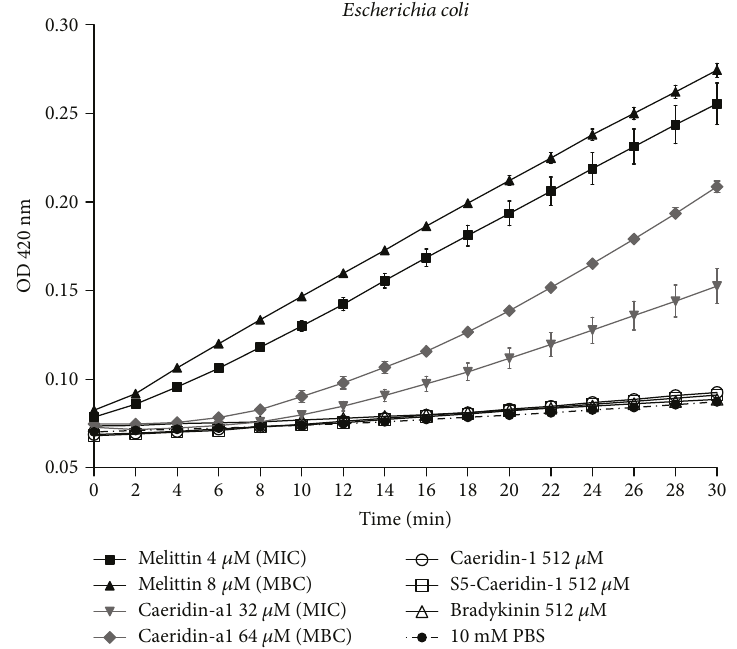
Figure 9: Membrane permeabilisation of E. coli treated with Caeridin-a1, Caeridin-1, S5-Caeridin-1, melittin, and bradykinin. The hydrolysis of ONPG generated by the release of cytoplasmic β -galactosidase of E. coli after treatment at MIC and MBC of Caeridin-a1, MIC and MBC of melittin, and maximum tested concentration of Caeridin-1, S5-Caeridin-1, and bradykinin was measured spectroscopically at 420 nm UV for 30min. Each point represents mean absorbance and SEM of three independent experiments and each experiment with fi ve